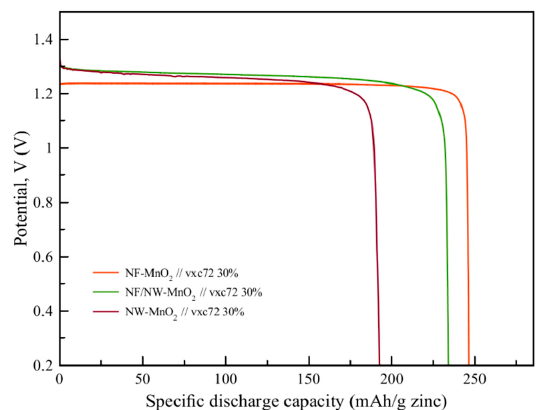
Figure 7. Galvanostatic discharge profiles of the Vulcan XC 72/commercial MnO 2 ,